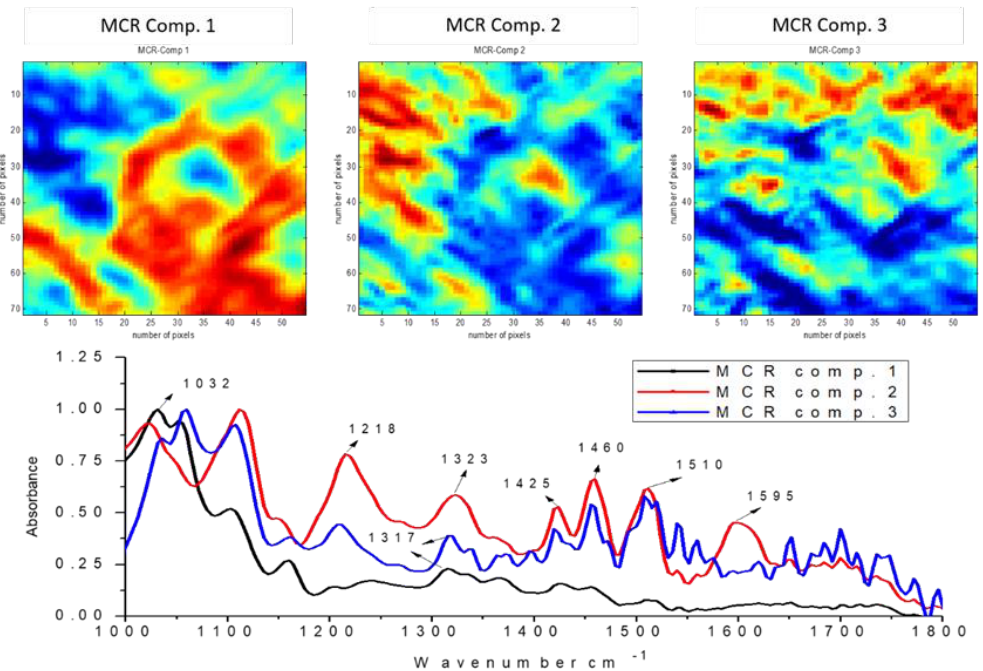
Figure 7. MCR−ALS relative concentration and recovered spectra of chemical components of pre−treated materials obtained by steam explosion. FT−IR micro-image of E. globulus pre-treated at severity S 0 10.42.